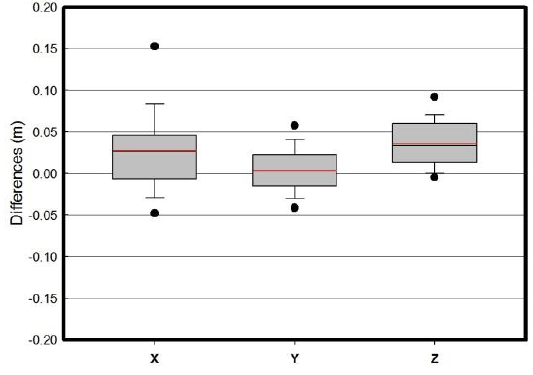
Figure 5. Differences between the Fast Static and RTX, for the three components of position Figure 6 represents the 3D differences between the fast